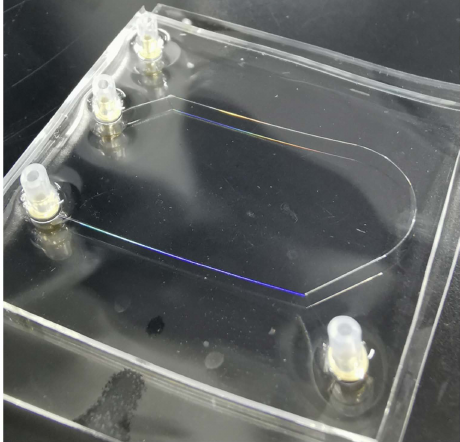
Figure 6. Image of the microfluidic device.